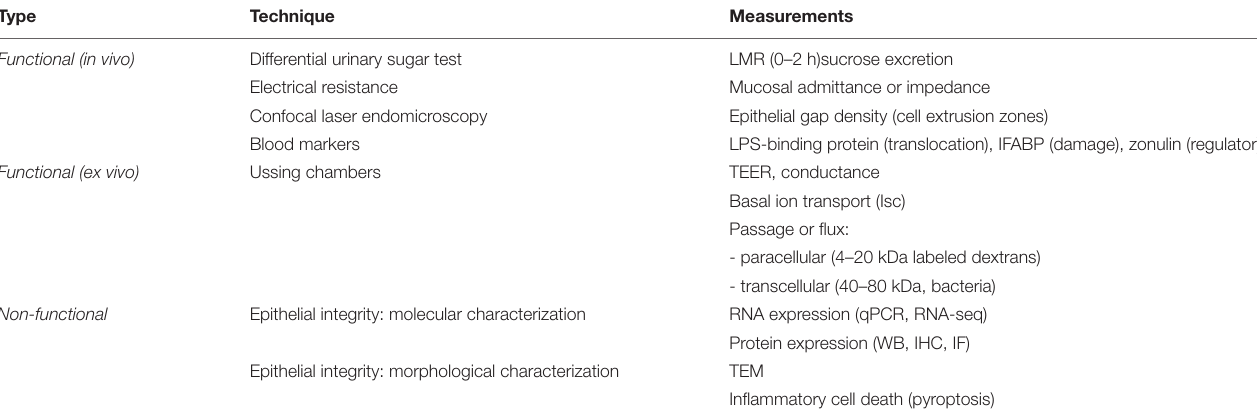
TABLE 1 | Techniques and measurements of duodenal barrier function in functional